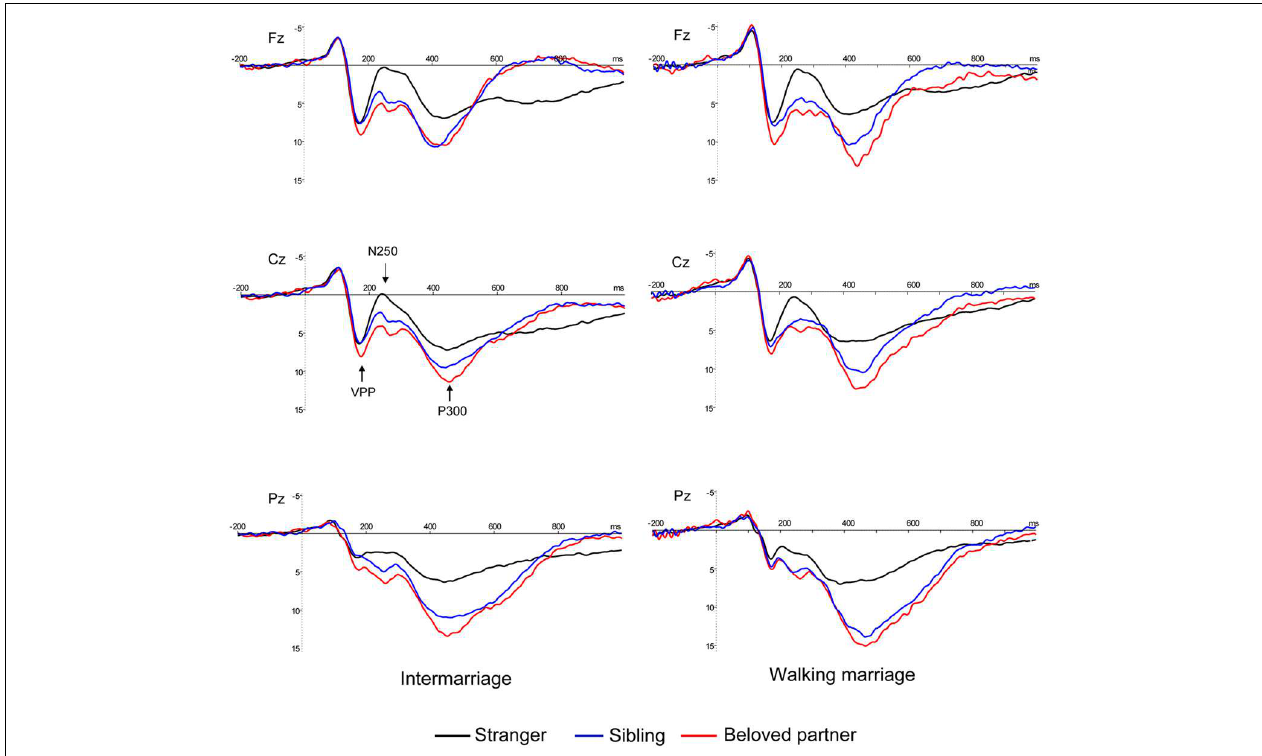
FIGURE 1 | Grand average ERPs at Fz, Cz, and Pz for two groups. Familiar faces (beloved and sibling) evoked more positive brain potentials than strangers from 200 to 600 ms for all sites. P300 (marked gray) was more positive for beloved face than sibling for both groups.